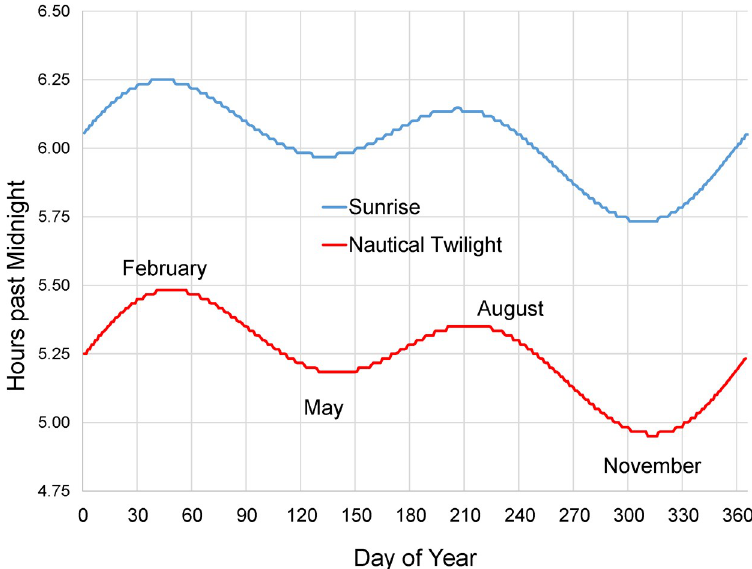
Fig 1. Annual cycle of sunrise and nautical twilight at Tiputini. Sunrise, the time when the edge of the sun first appears above the horizon, and nautical twilight, the time when the sun is 12 º below the horizon, at the Tiputini Biodiversity Station (76˚08’ W, 0˚38’ S). Day 1 is January 1. Values were downloaded from the website of the US Naval Observatory (http://www.usno.navy.mil/USNO/astronomical-applications); they vary only 1–2 min from year to year. Curves are averages for years